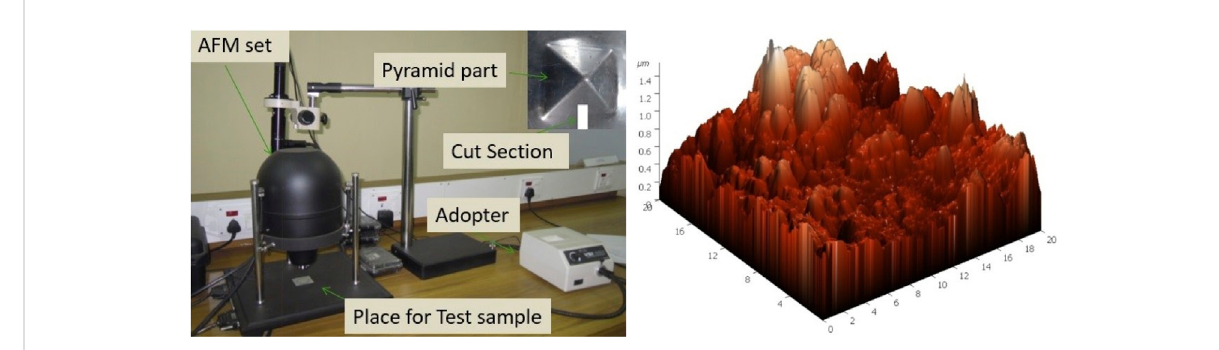
FIGURE 2 AFM utilized in the measurement of Ra and generated 3D view of the SPIF part surface.